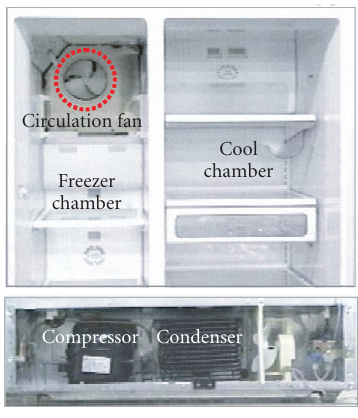
Figure 2: Cross section of refrigerators.